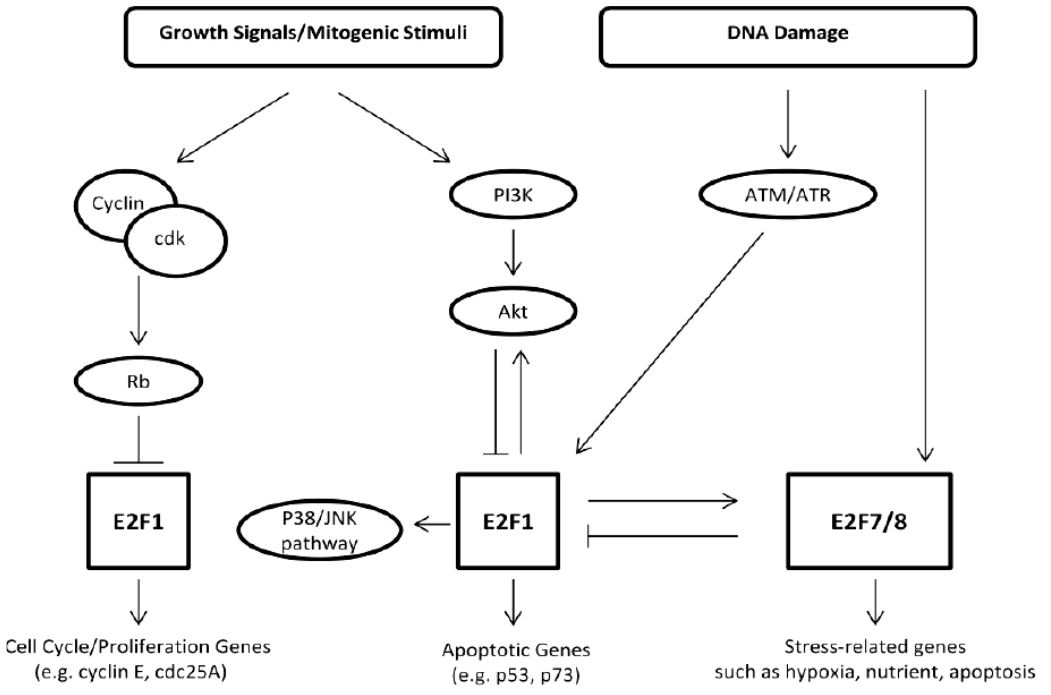
Figure 3. Regulatory network on Regulatory network on E2F1 and E2F7/8 activity representing upstream events (growth-dependant and/or DNA dependant and/or DNA damage mediated activation) and downstream targets. damage mediated activation) and downstream targets.